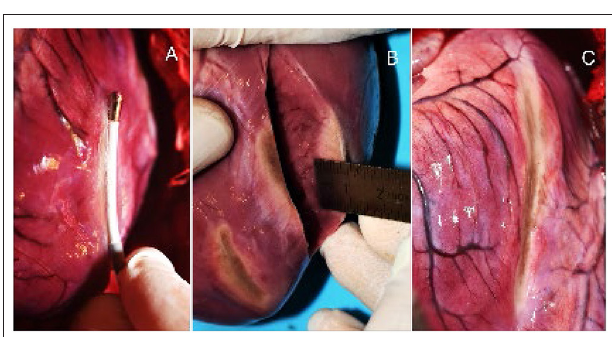
FIGURE 5 | (A) Epicardial ablation of the LV with the laser ablations catheter. (B) Axial section of the excised heart and macroscopic estimation of the lesion depth. (C) 4 connected ablations with approx. length of